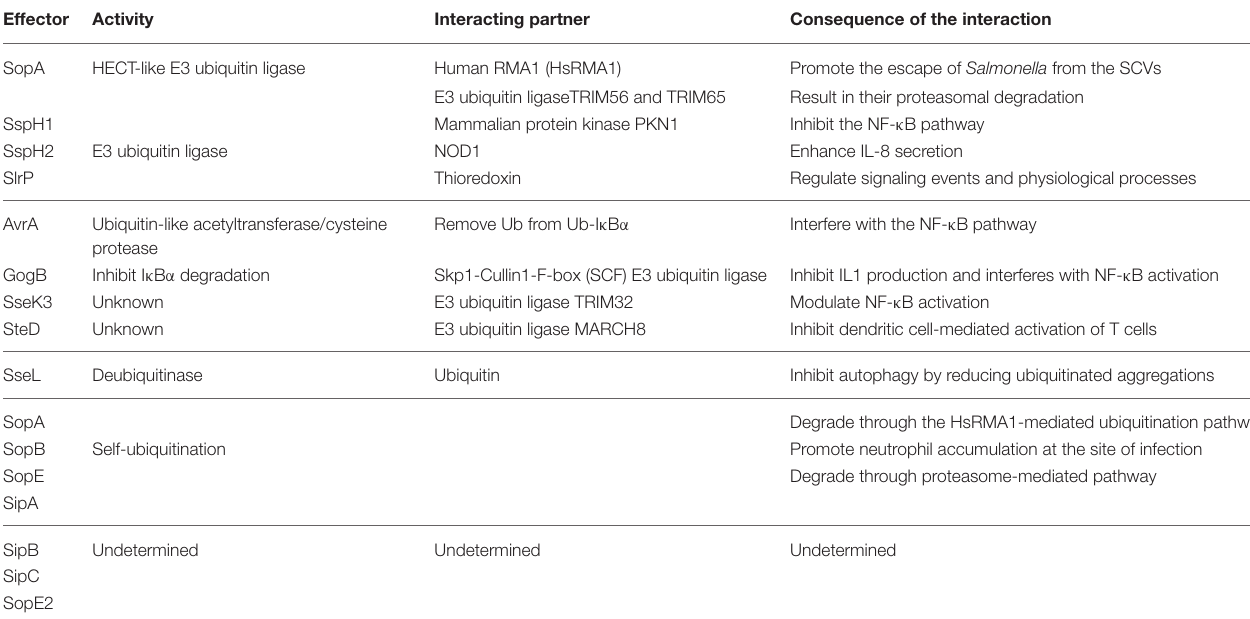
TABLE 1 | Salmonella T3SS effector proteins that interact with the eukaryotic ubiquitin